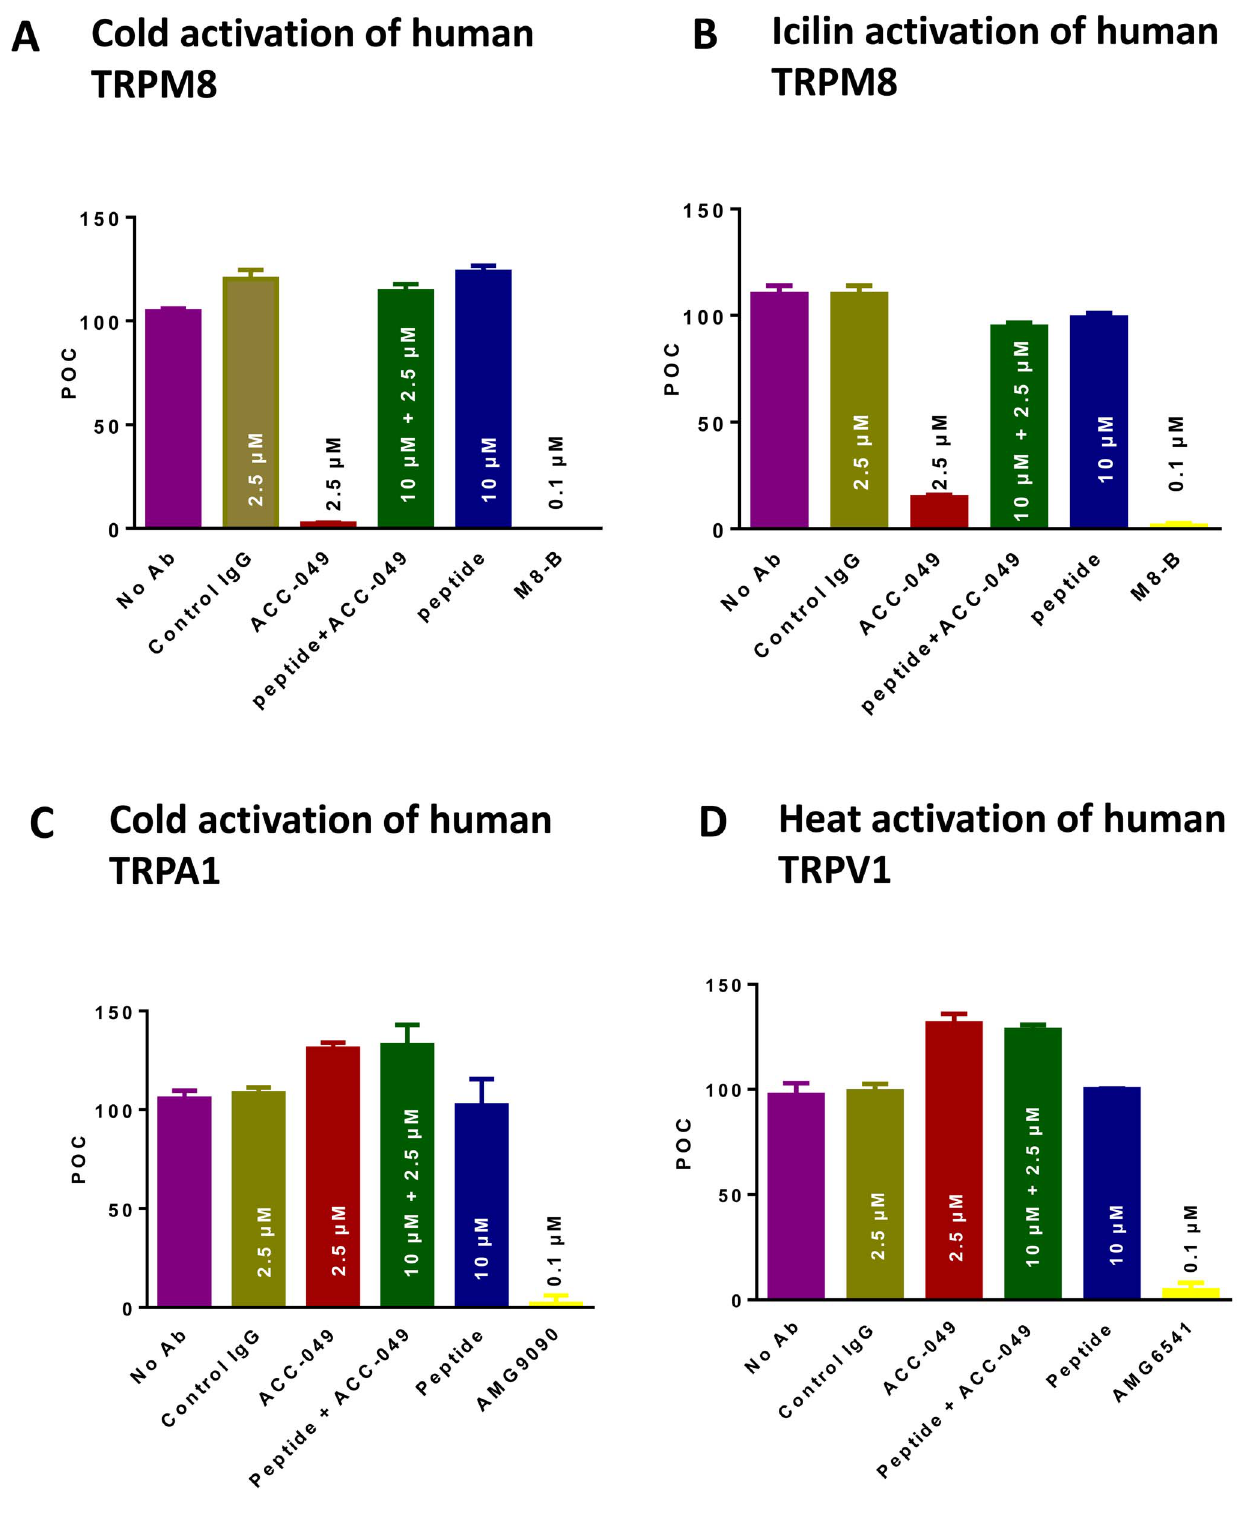
Figure 2. ACC-049 is a selective inhibitor of TRPM8. Specificity of ACC-049 (2.5 m M) for blocking human TRPM8 activation induced by the specific natural agonist cold (A) or synthetic agonist icilin (D). No effect of ACC-049 on noxious cold induced human TRPA1 (B) or heat induced TRPV1 activation (C). Small molecule antagonists AMG9090 and AMG6541 are the positive control for TRPA1 (B) or TRPV1 (C) blockage, respectively. Note the near complete blockade of TRPM8 activation by ACC-049 at 2.5 m M, similar to that by the positive small molecule antagonist control M8-B (A). Neither control IgG, nor peptide-absorbed ACC-049, or peptide alone blocked activation of any of the channels tested (A–D). Values are means of triplicate measures in a single experiment and expressed as percent of control (POC). Agonist induced 45 Ca 2 + uptake in the absence of antibodies (no Ab) was considered as 100 percent and wells with small molecule antagonists plus 45 Ca 2 + were set as zero percent. doi:10.1371/journal.pone.0107151.g002 PLOS ONE |